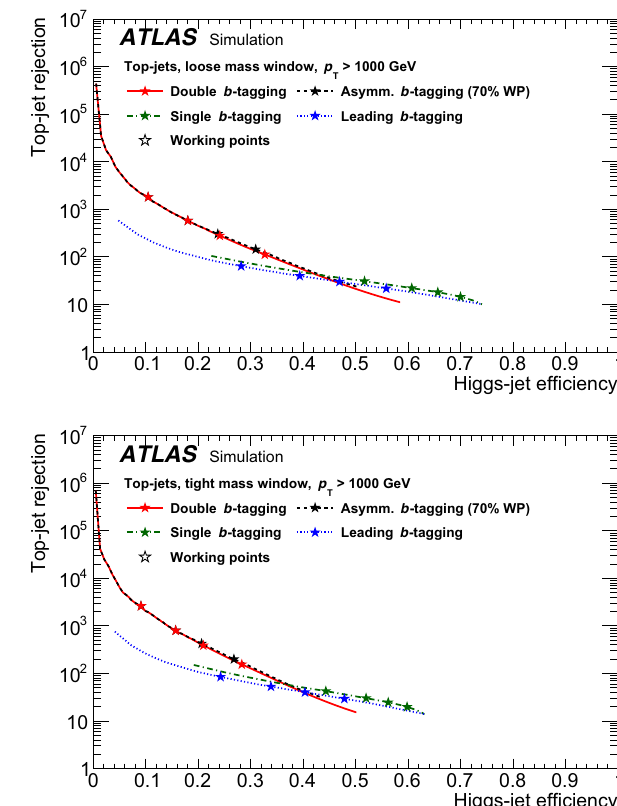
spond to the 60%, 70%, 77% and 85% b -tagging WPs (from left to right). The curves for the double- and asymmetric- b -tagging working points coincide over a large range of Higgs-jet